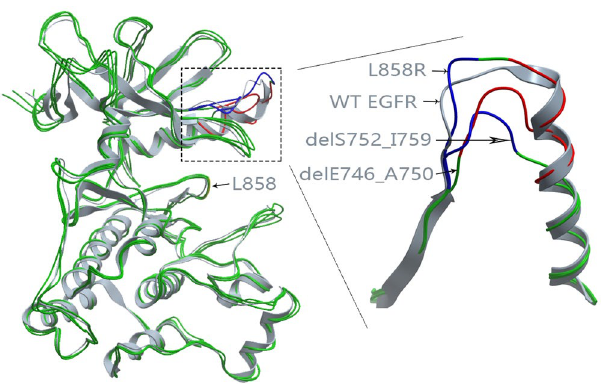
segments of 3W2S (residues 987–1019). In ( C , D ), the yellow part (2ITY) and the grey part (3IKA or 3W2S) aligned very well. The red segments replaced the corresponding yellow segments to generate the complete WT EGFR structure.